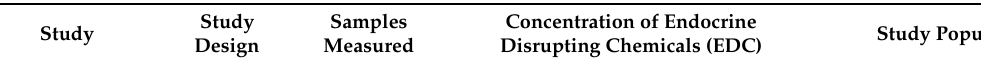
Table 4. Exposure to benzophenones and